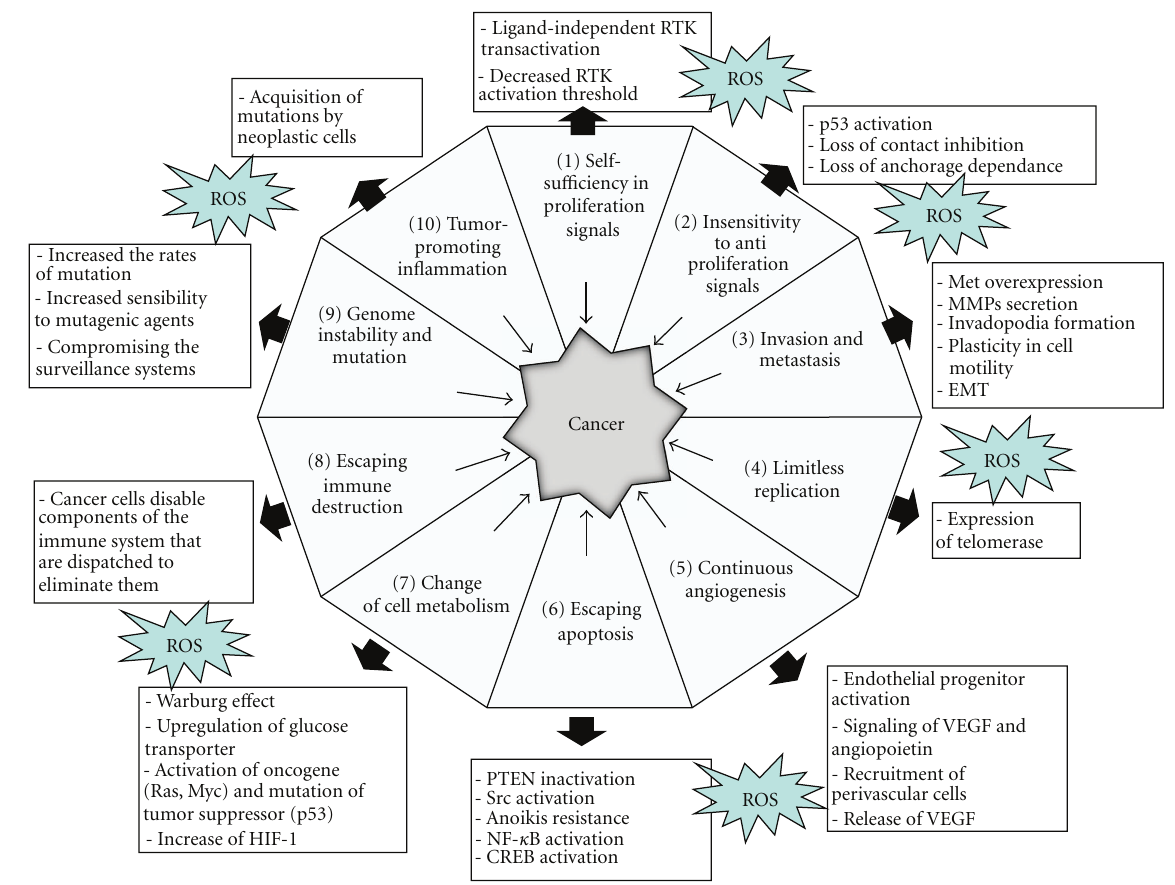
Figure 1: ROS play multiple roles in the hallmarks of cancers. Contribution of oxidants is indicated for each point (see text for details). (1) Self-su ffi ciency in proliferation signals: most normal cells wait for an external message before dividing. Conversely, cancer cells often counterfeit their individual proliferative messages. ROS a play role in ligand-independent RTK transactivation, decreased RTK activation threshold [11, 12]. (2) Insensitivity to antiproliferation signals: as the tumor enlarges, it squeezes adjacent tissues and therefore receives messages that would normally stop cell division. Malignant cells ignore these command. ROS are involved in p53 activation, loss of contact inhibition, and loss of anchorage dependence [12–14]. (3) Invasion and metastasis: cancers usually lead to death only after they overcome their confines to the particular organ in which they arose. Cancer cells need to escape the primary tumour, invade matrix of di ff erent organs, find a suitable metastatic niche, and then grow in this secondary site. ROS play a role in Met overexpression, matrix metalloproteinase secretion, invadopodia formation, and plasticity in cell motility, EMT [12, 15–18]. (4) Limitless replication: healthy cells can divide no more than 70 times, but malignant cells need more than 70 cycles to make tumours. Hence tumours need to enforce the reproductive limit of cells. ROS are involved in expression of telomerase [12, 19]. (5) Continuous angiogenesis: tumour is characterized by a chronically activated